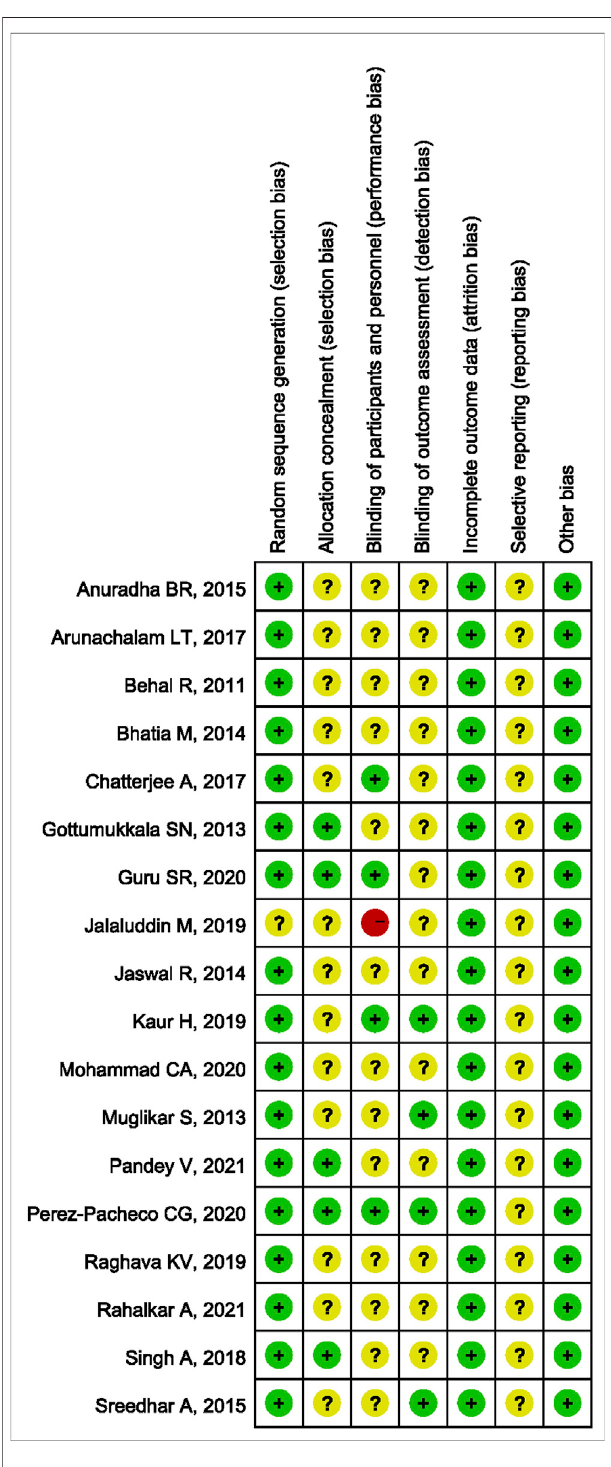
FIGURE 3 | Risk of bias